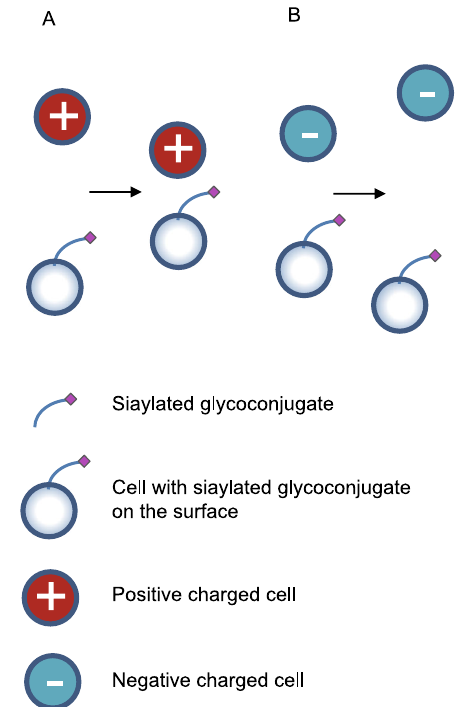
Figure 3. Sialic acid that on cell surface provides charge adhesion to positive cells (A) and charge repulsion to negative cells